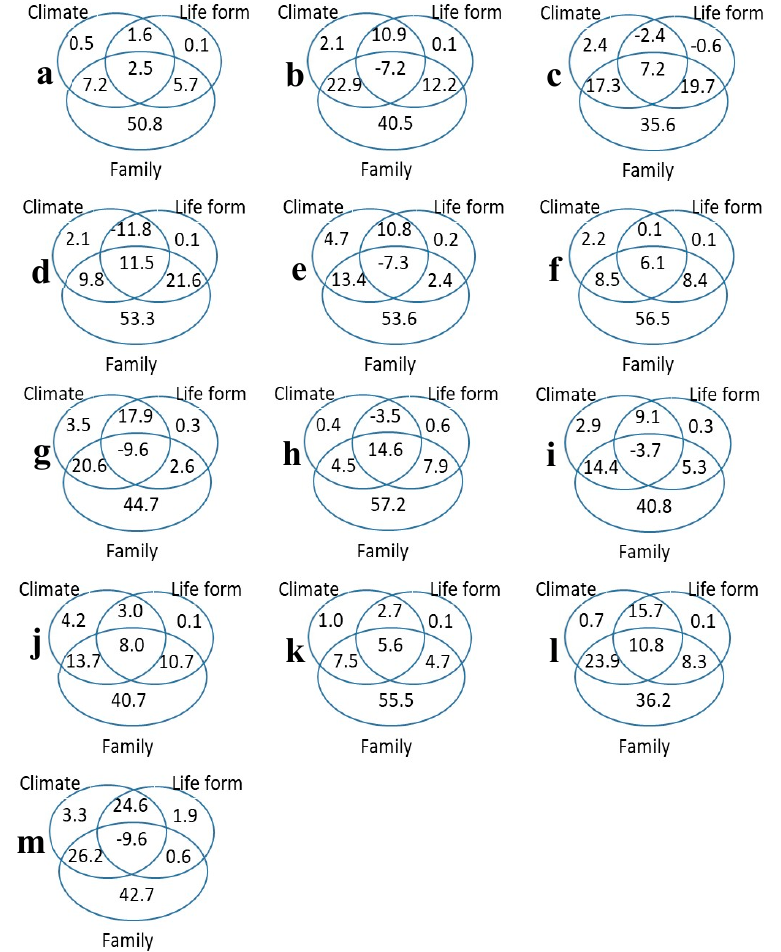
Figure 2. The variance partitioning (%) for all traits considered together, and each trait separately. ( a ) LA, leaf area (m 2 ); ( b ) SLA, Specific leaf area (m 2 /kg); ( c ) LMA, Leaf mass per unit area (kg/m 2 ); ( d ) LDMC, Leaf dry matter content (mg/g); ( e ) C mass, Leaf carbon content (g/kg); ( f ) N mass, Leaf nitrogen content (g/kg); ( g ) P mass, Leaf phosphorus content (g/kg); ( h ) K mass, Leaf potassium content (g/kg); ( i ) N area, Leaf nitrogen content per unit area (g/m 2 ); ( j ) P area, Leaf phosphorus content per unit area (g/m 2 ); ( k ) K area, Leaf potassium content per unit area (g/m 2 ); ( l ) d13C:12C, The ratio of 13C to 12C stable isotopes in the leaf (unitless); ( m ) d15N:14N, The ratio of 15N to 14N stable isotopes in the leaf (unitless).